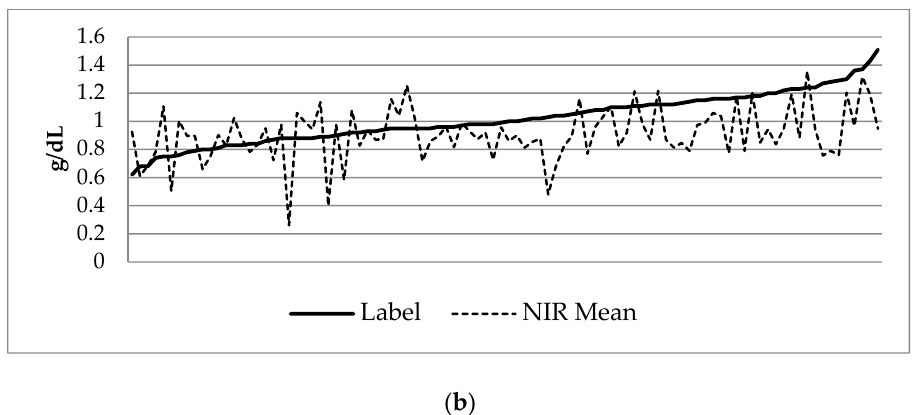
Figure 2. Labeled (solid line) vs. mean NIR analysis (dashed line) of ( a ) caloric and ( b ) protein content, ordered by increasing labeled values.